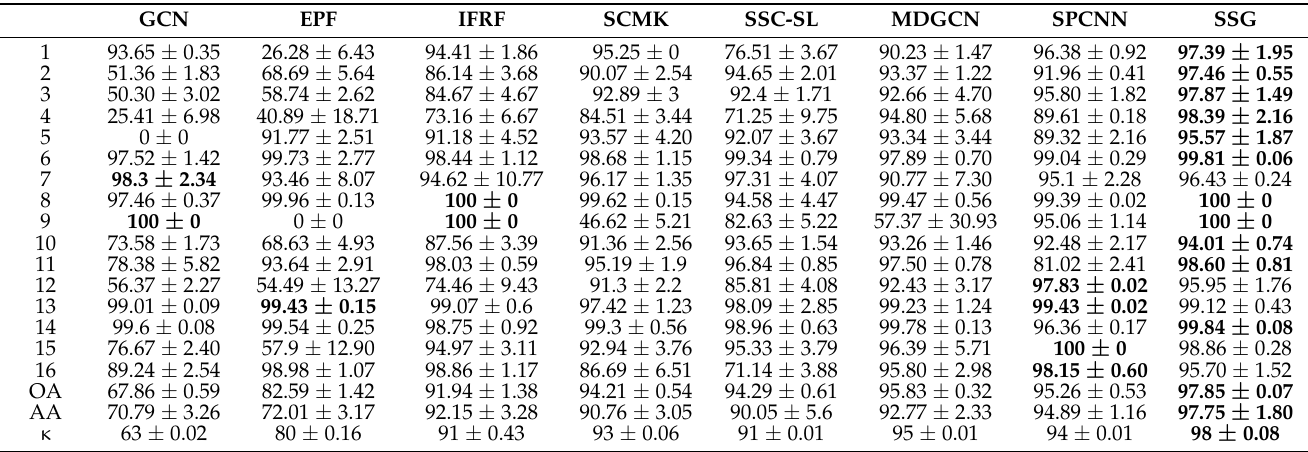
Table 2. Classification results (%) of eight methods for Indian Pines